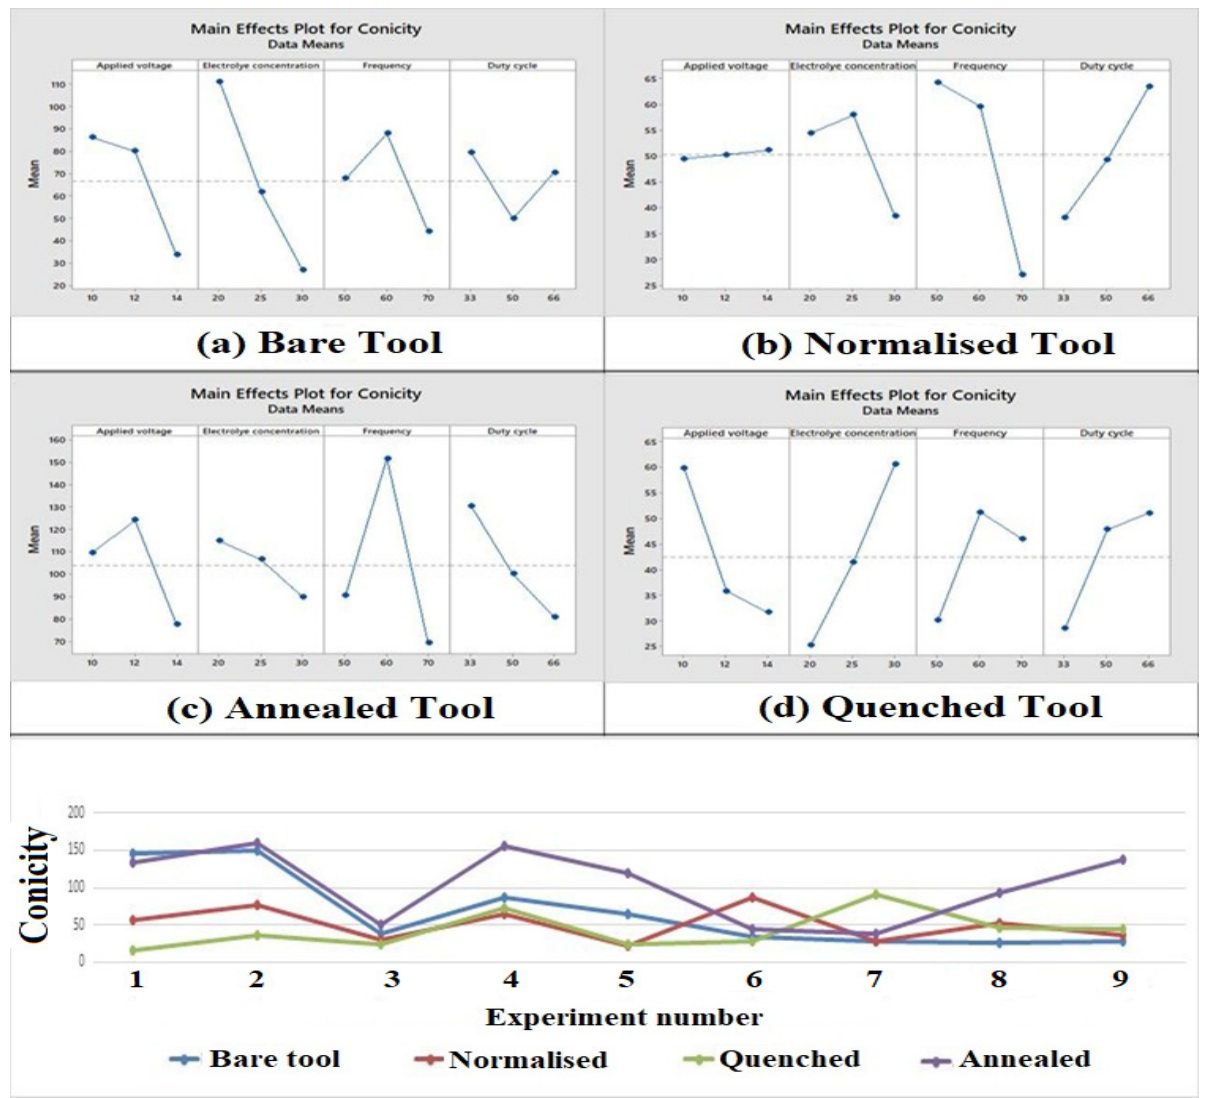
Figure 6. Main effect plots and comparison plot of conicity for tool electrodes. ( a ) Bare tool; ( b ) Normalized tool; ( c ) Annealed tool; ( d ) Quenched tool.